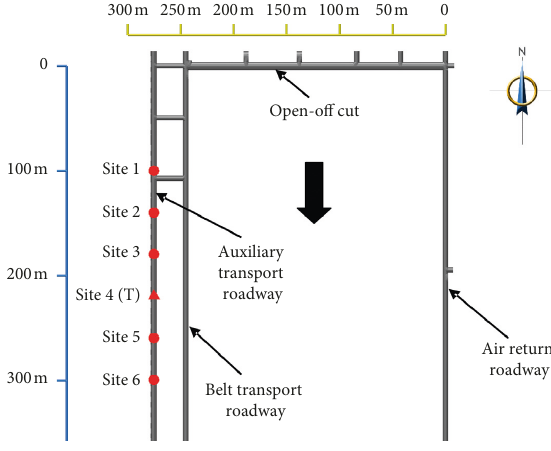
Figure 2: Specific arrangement of MS monitoring. Table 1: Locating results of the blasting